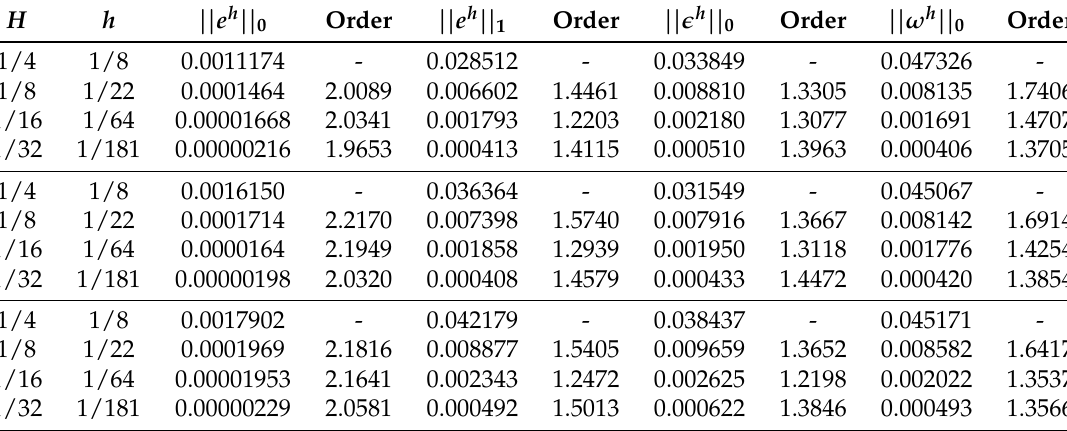
Table 2. Two-level method for Oseen viscoelastic fluid flow for λ = 5.0,1.0,and 0.1 with P 2 − P 1 − P 1 dc finite